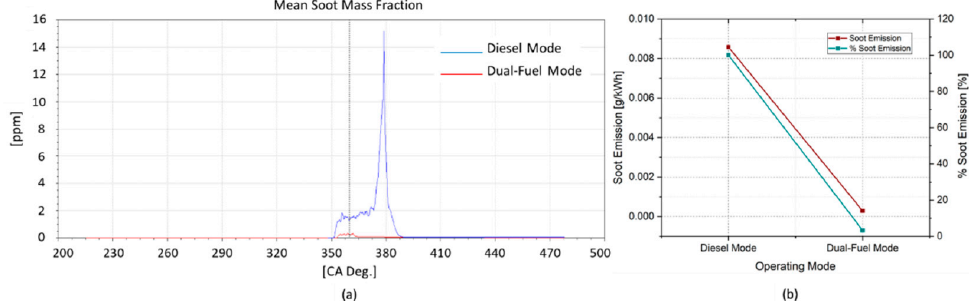
Figure 15. The mean soot mass fractions ( a ) and soot emission masses ( b ) in both combustion